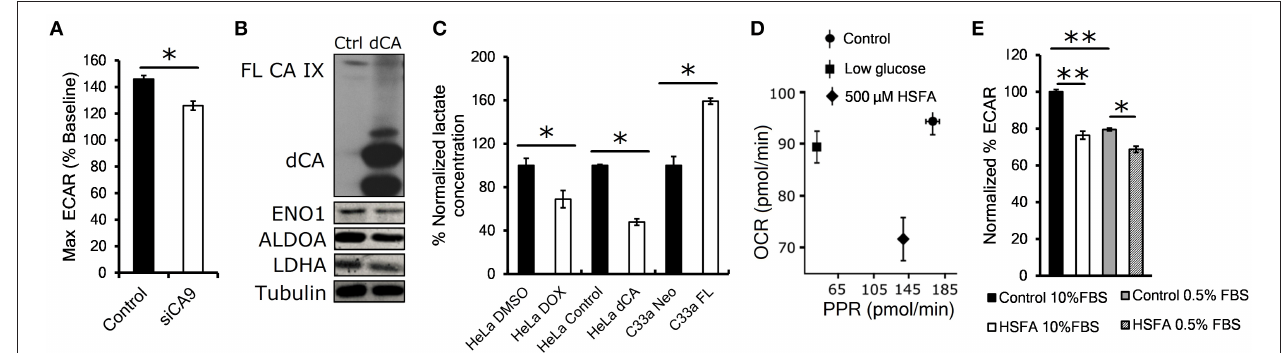
FIGURE 2 | Catalytic activity of CA IX maintains glycolytic flux. (A) Maximum glycolytic flux rate of HT-1080 KD cells incubated for 24h in 1% O 2 , treated with oligomycin A after establishing baseline ECAR (extracellular acidification rate). (B) Representative western blot showing decreased levels of glycolytic enzymes ENO1, ALDOA and LDHA in HeLA dCA cells that overexpress CA IX lacking the catalytic domain (dCA, right lane). HeLa dCA cells were incubated in 2% O 2 for 48h ( n = 3), the full length CA IX (FL CA IX) is shown in the top of the blot (C) Normalized extracellular lactate concentration of HeLa DOX, HeLa dCA, and C-33A-FL cells incubated in 2% O 2 for 48h. Mean baseline lactate concentrations are: Hela DMSO 0.11mM, HeLa DOX 0.08mM, HeLa Control 0.09mM, HeLa dCA 0.04mM, C-33A-Neo 0.16mM, C-33A-FL 0.26mM. (D) Seahorse analysis of oxygen consumption rate (OCR) and proton production rate (PPR) in posthypoxic parental HT-1080 cells in low glucose (1mM) or with CA IX inhibitor 4-aminometylbenzensulfonamid (HSFA). (E) Normalized ECAR in HT-1080 cells pre-incubated in 1% O 2 for 24h in 10 and 0.5% serum. After establishing the baseline, the cells were treated with HSFA for 30min (right). Error bars are ± SD. P -values were calculated against Control by t-test. * P < 0.05; ** P <